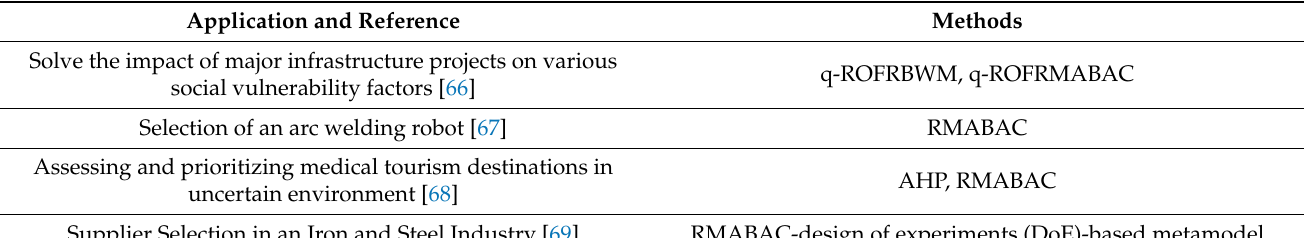
Table 3. Rough MABAC method—analysis of the